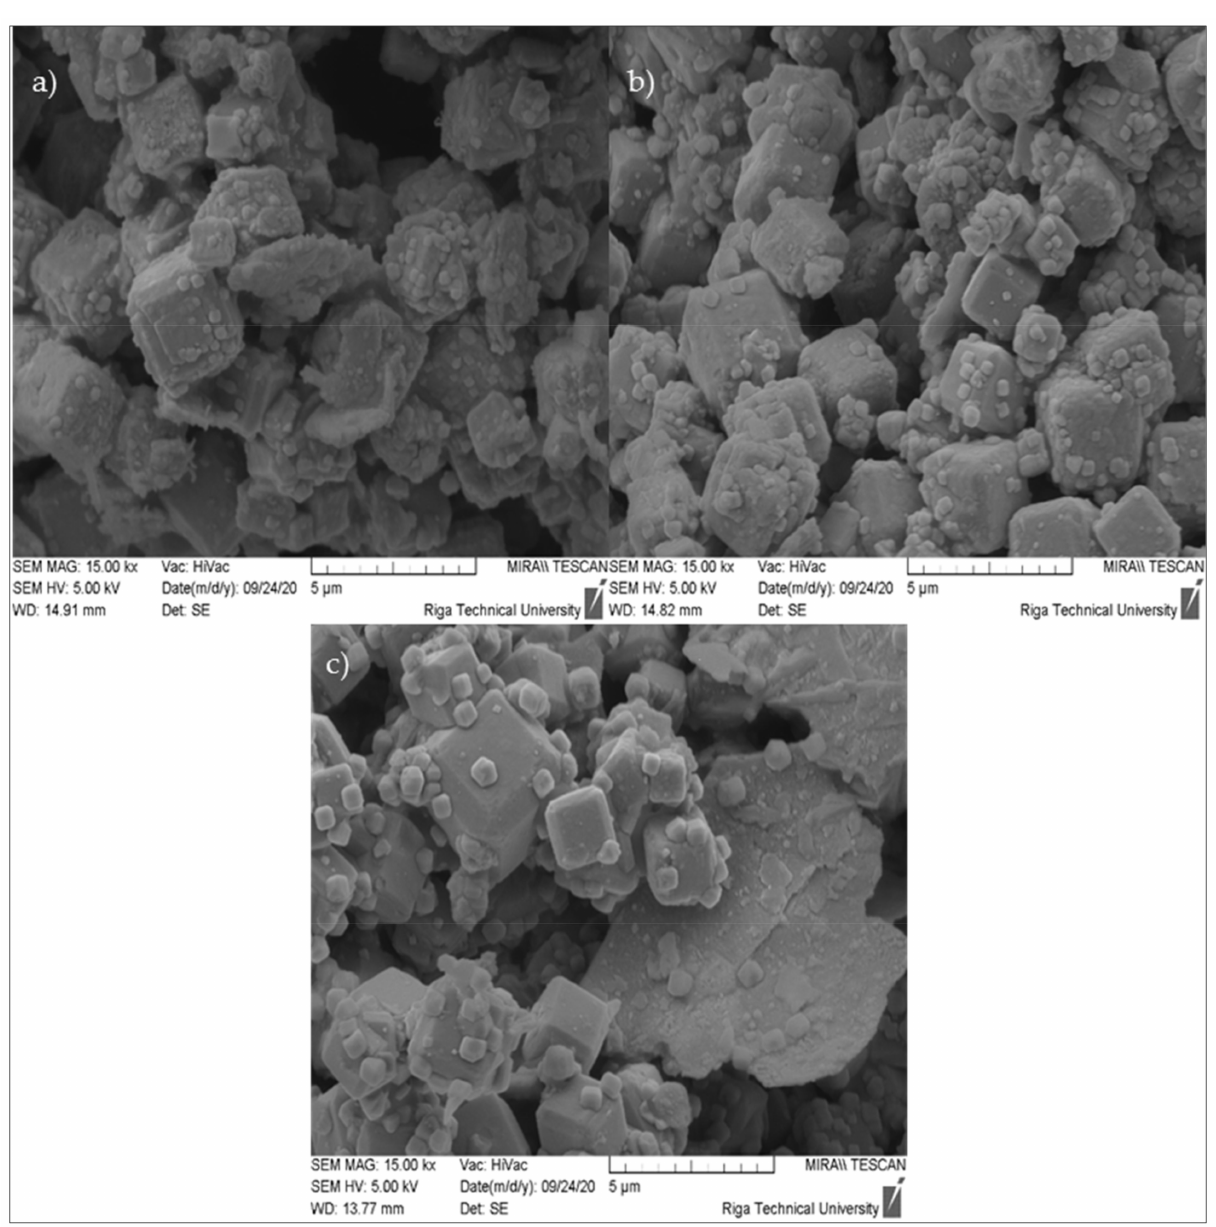
Figure 14. SEM micrographs of ZG samples (cross-section) at 15,000 × magnification: ( a ) ZG-0.8; ( b ) ZG-1.0; ( c )